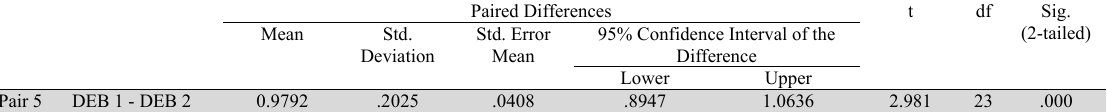
Paired Differences